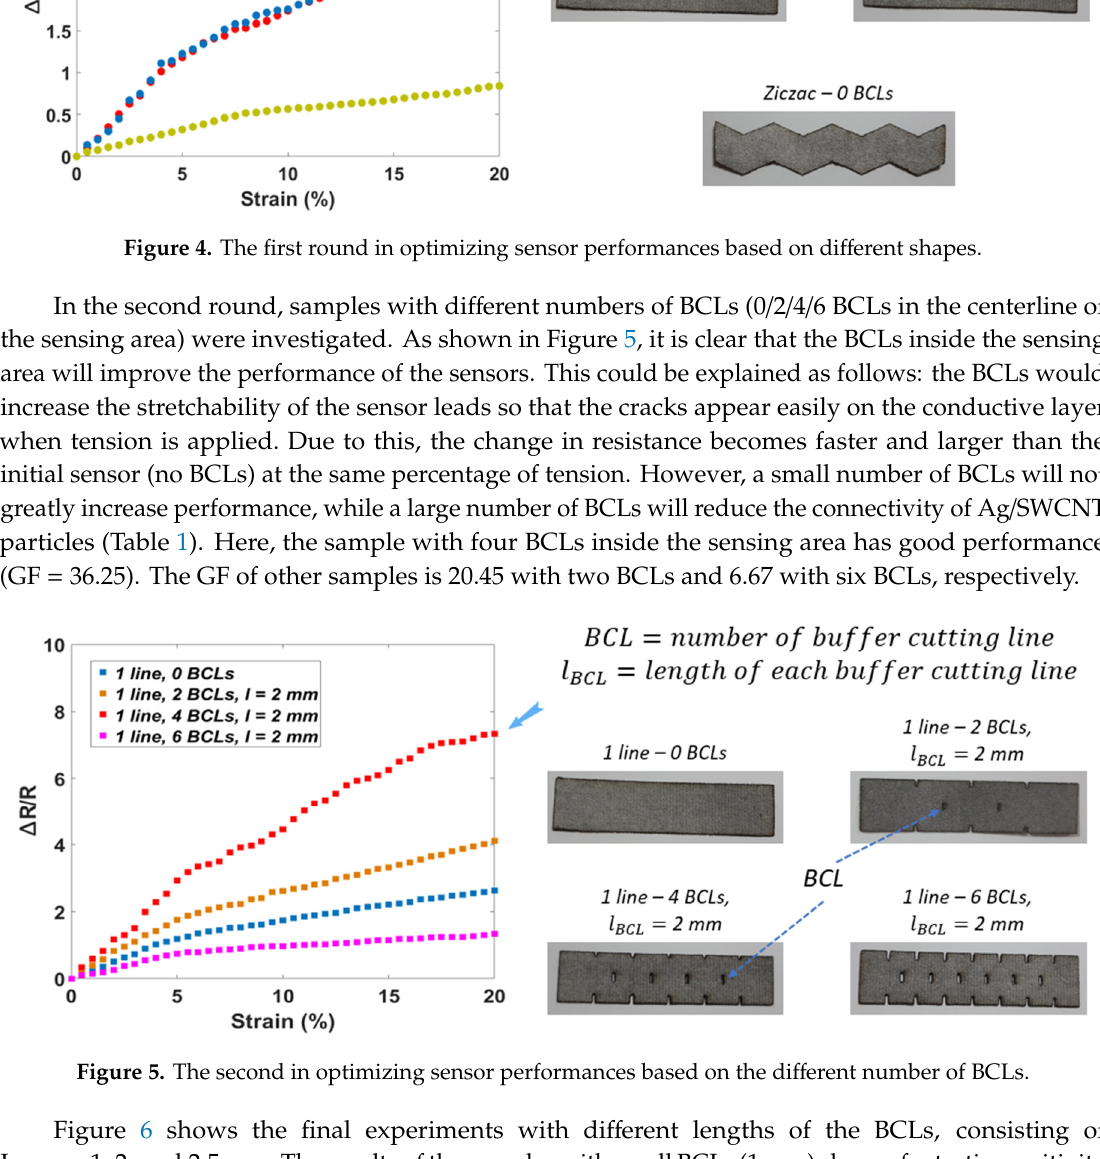
Figure 5. The second in optimizing sensor performances based on the different number of BCLs.